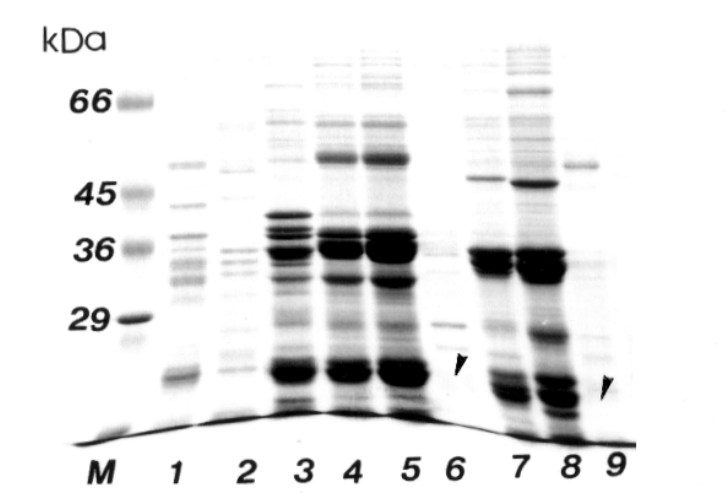
FIGURE 2. SDS-PAGE electrophoretogram of seed proteins of different lines and species of buckwheat. Lane 1: F. esculentum ; Lane 2: F . capillatum ; Lane 3: F. homotropicum #1; Lane 4: F . homotropicum #2; Lane 5: F . homotropicum #4; Lane 6: F . lineare ; Lane 7: F . tataricum (cid:150) potany; Lane 8: F . tataricum- cm 198; and Lane 9: F . urophyllum . The arrowheads indicate the absence of the 22-kDa protein.